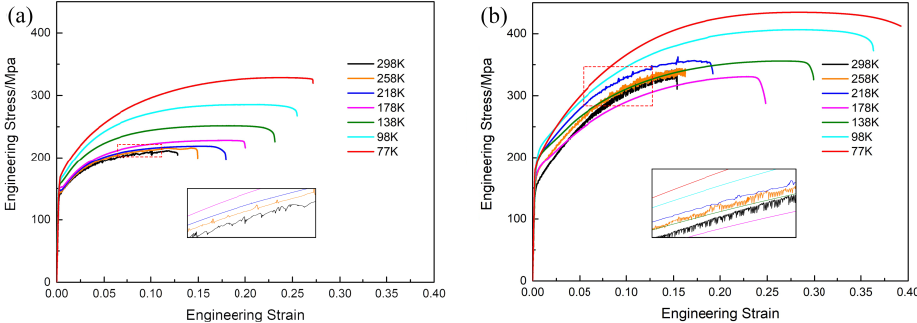
Figure 3. Engineering stress–strain curves of 2195 alloy at 298 K to 77 K: ( a ) O-state, and ( b )